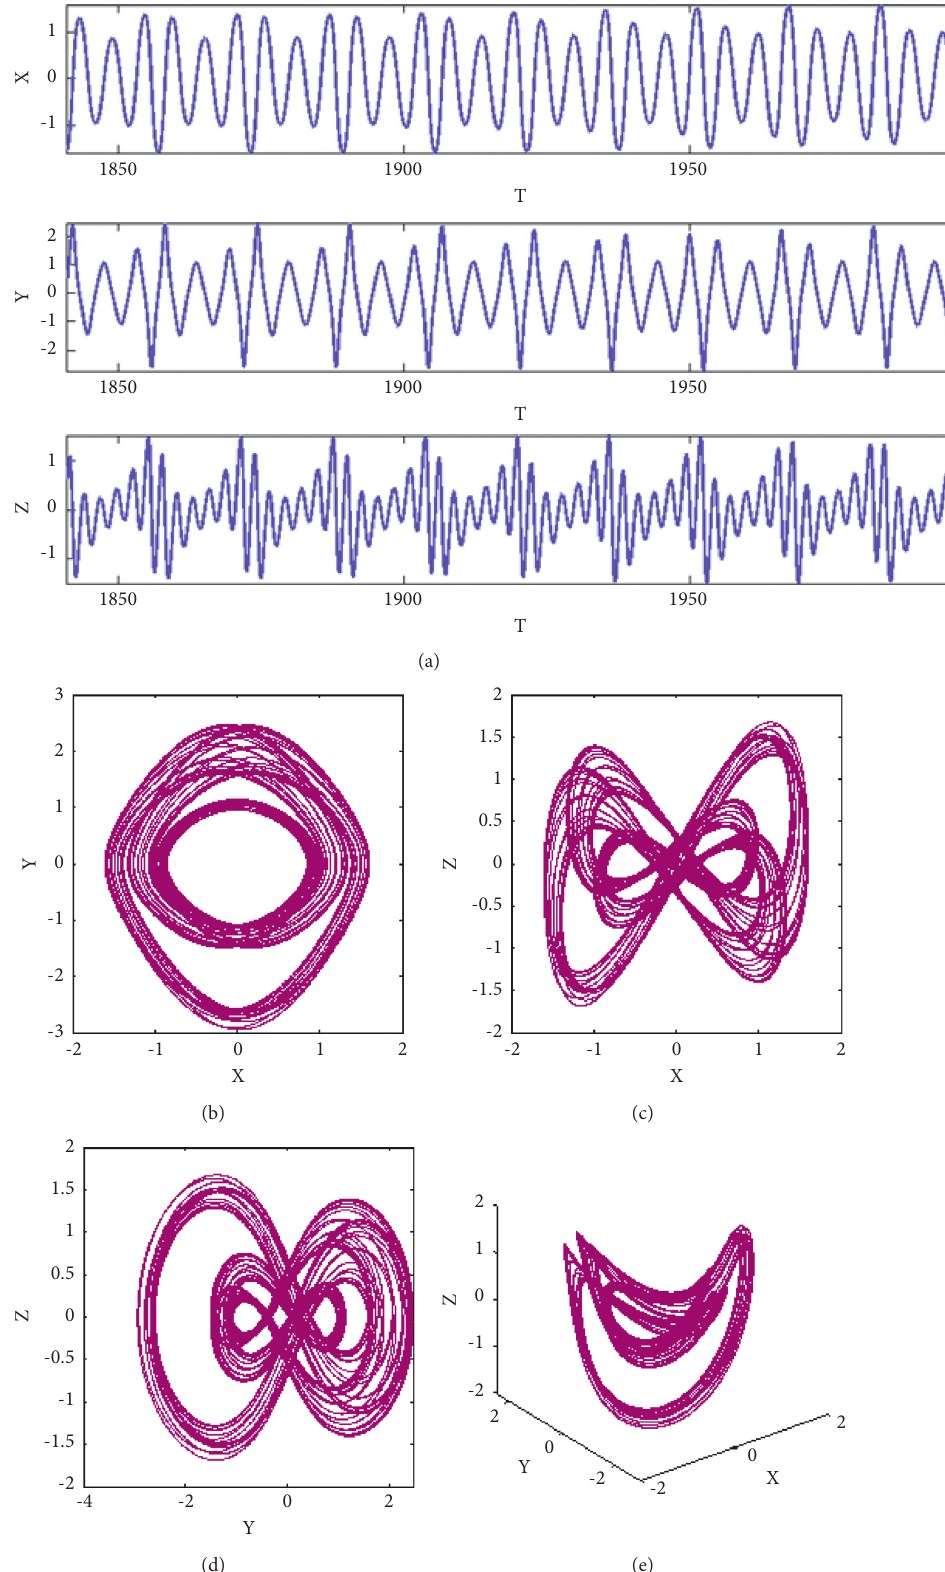
Figure 1: Time series (a) and chaotic sea with initial condition ( x 0 , y 0 ,z 0 ) � (− 0 . 57 − 0 . 99 − 0 . 71 ) and parameters ( a,b ) � ( 1 , 0 . 68 ) in (b) X Y , (c) X − Z , (d) Y − Z , and (e) X Y Z